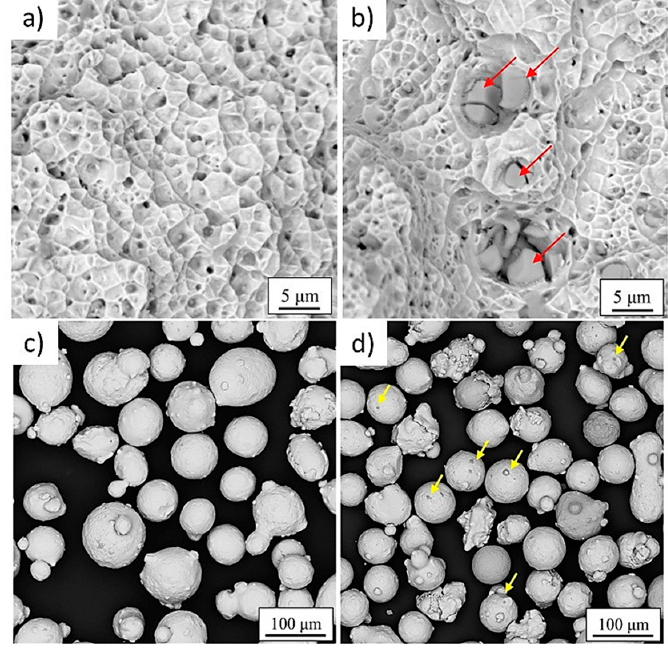
Figure 14. A summary of the tensile fracture morphologies of AISI 316L stainless steel samples produced by DED using ( a ) fresh powder and ( b ) recycled powder. SEM images of ( c ) fresh and ( d ) recycled AISI 316L powders [37].